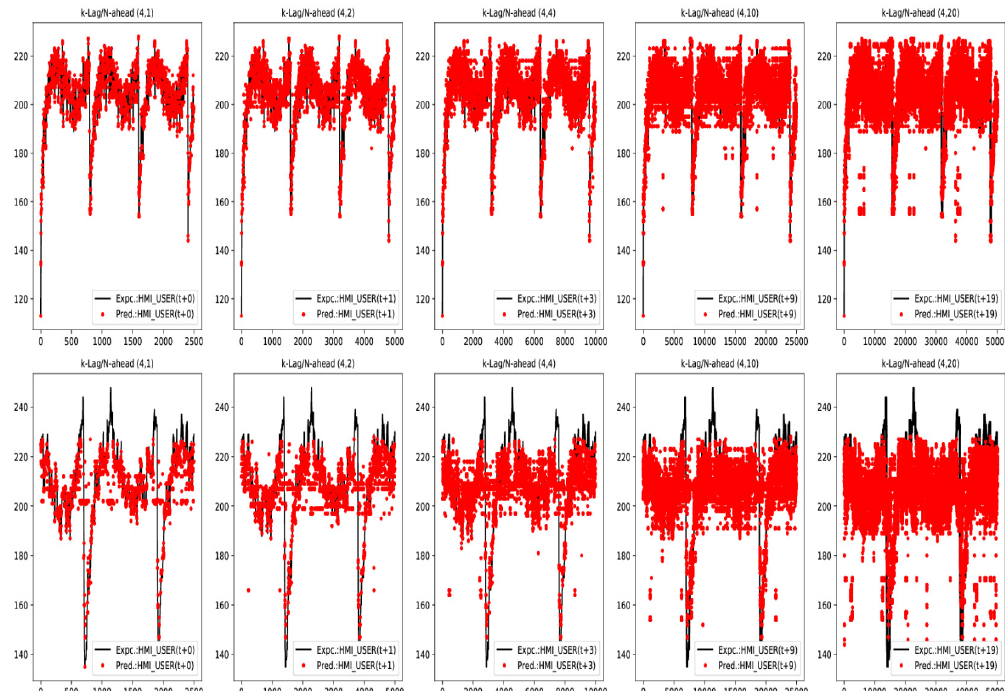
Figure 18. LSTM E-D Model—Expected(solid line) vs. Predicted(red dots) Operator response traces for Teacher Forcing test case from In-Sample (top row) & Out-of-Sample (bottom row) data set test under K-Lag = [ 4 ] and N-Step = [ 1,2,4,10,20 ] runs (in left to right order).